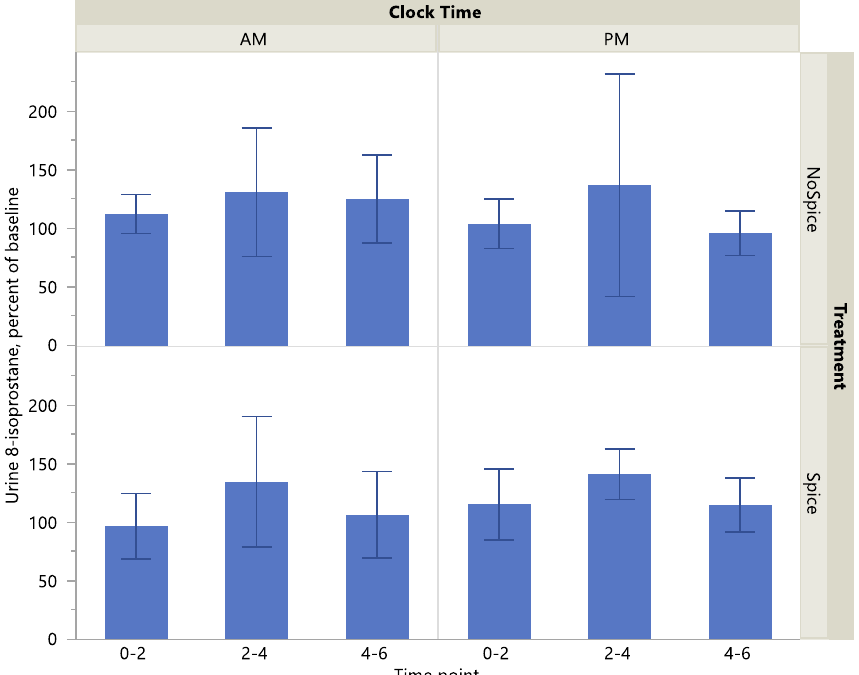
Figure 2. Urine 8-isoprostane as percent of baseline by treatment, clock time and time point. Values are means with standard deviation. Values tended to be higher at the 2–4-hour compared to 0–2- and 4–6-hour time points ( p = 0.05), but showed no significant effect of treatment or clock time ( p > 0.05).